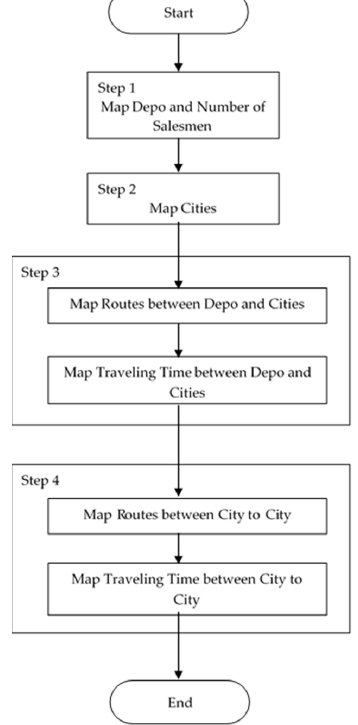
Table 1. Algorithm to map mTSP onto CPN.